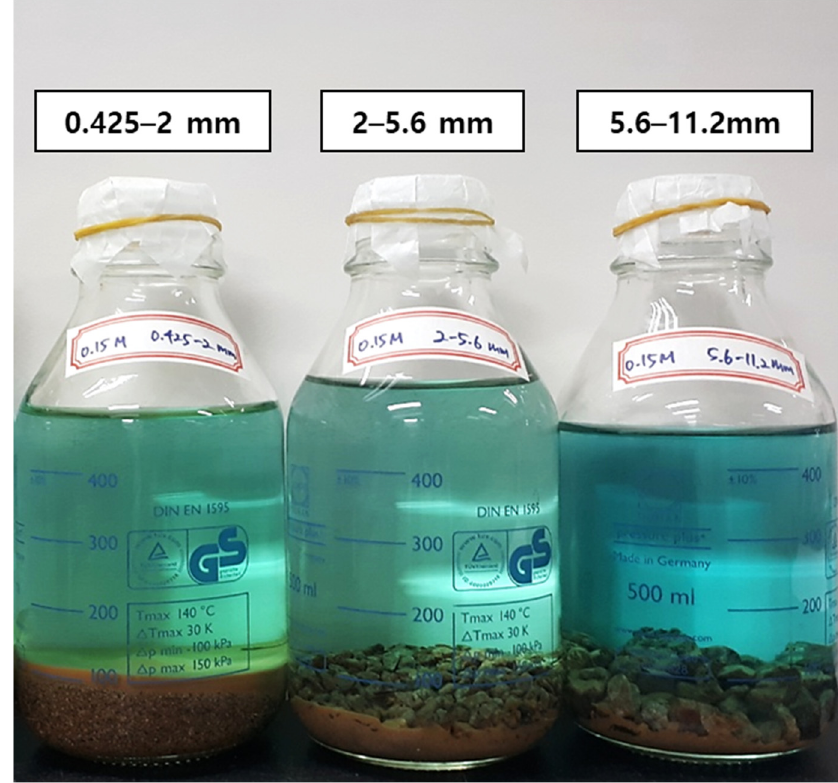
Figure 4. Pregnant leaching solution after weeklong (7 days) reaction.